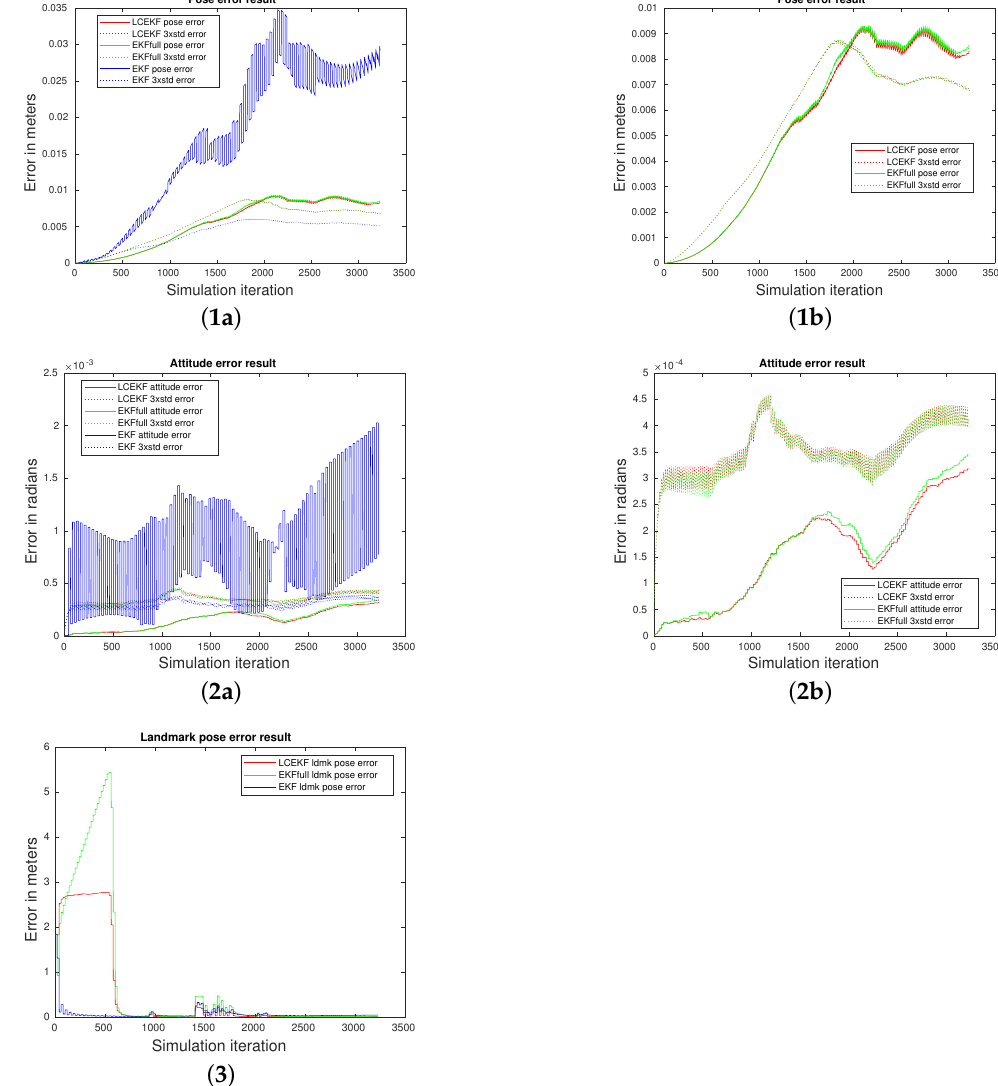
Figure 9. SLAM with periodic noise (Case v): methods’ comparison. Figures ( 1a ) and ( 2a ) represent the MSE of the pose and attitude estimation over 100 executions for the three methods. As the EKF results hide the two other, the same results without the EKF are presented in Figures ( 1b ) and (2b ). Full lines are the mean of the estimation, and dotted line represent the 3 sigma value. Figure ( 3 ) represents the MSE of the landmark convergence during the